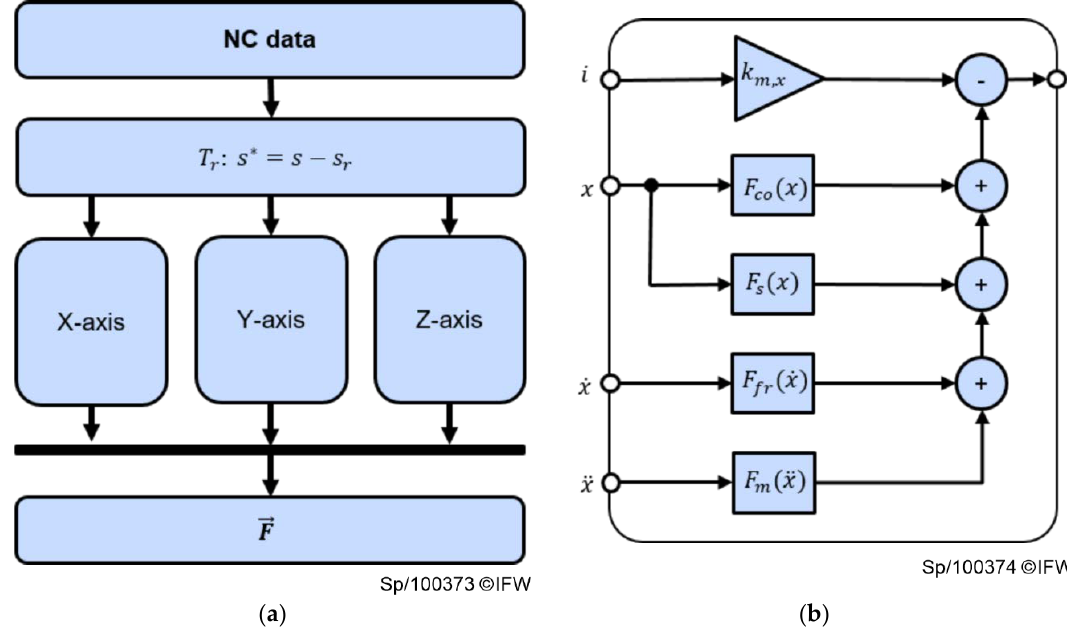
Figure 1. Model-based approach: ( a ) complete model; ( b ) X -axis submodel. Third, the friction is reconstructed by a Stribeck curve, described by Equation (4) To parametrize the model, axis movements are performed without tool engagement.